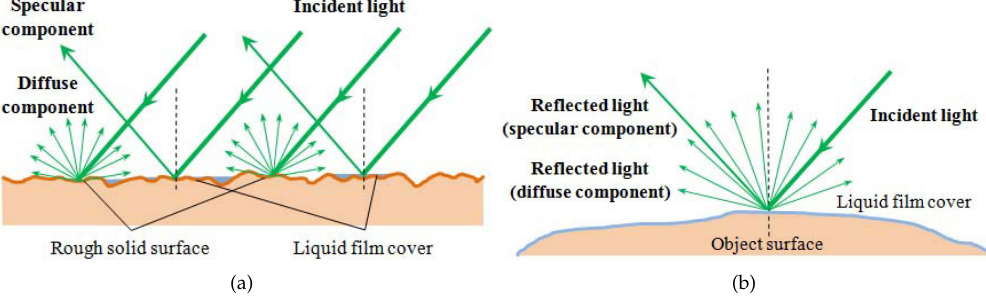
Figure 5. Lambertian reflection and specular reflection on the digestive tract. ( a ) Reflection on the digestive tract surface observed from a microscopic viewpoint. ( b ) General reflection model of the non-ideal Lambertian surface.